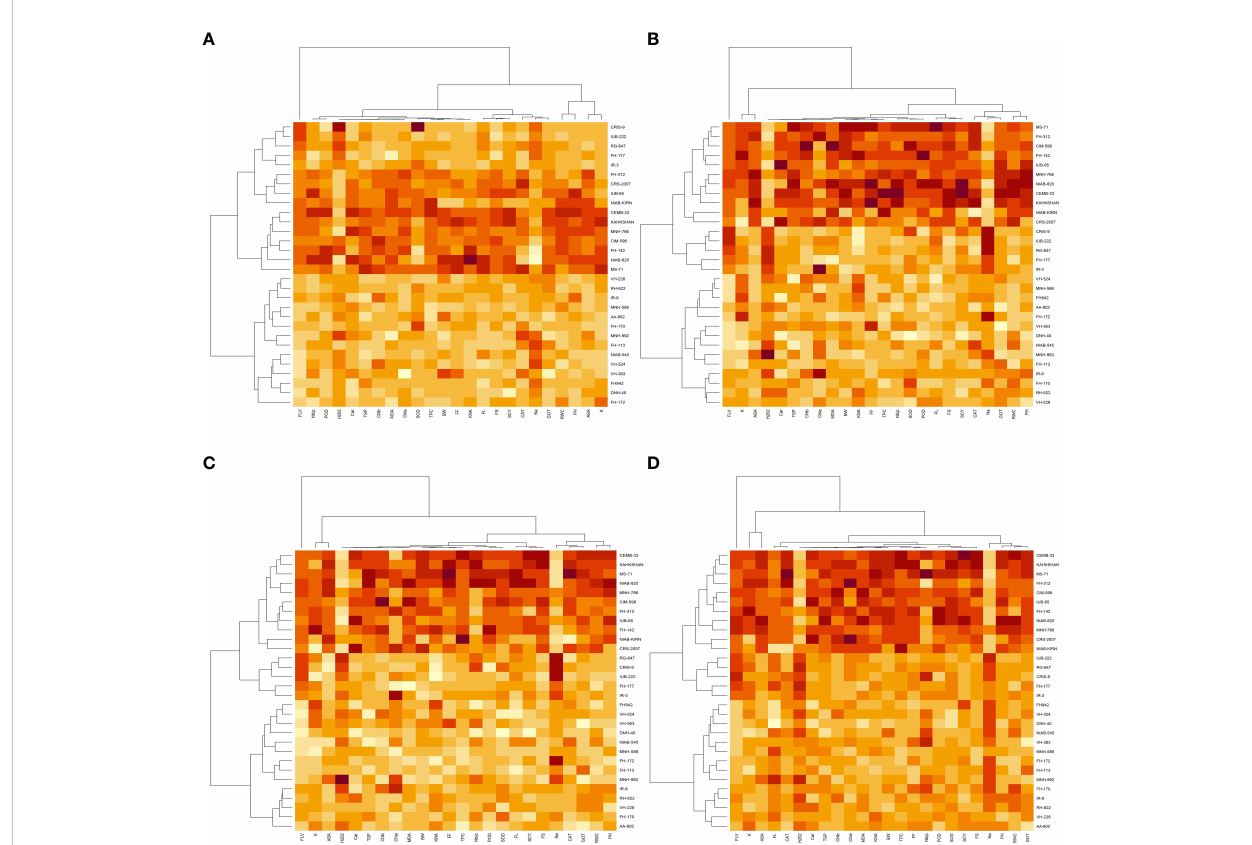
FIGURE 5 First year correlation analysis based on mean values of various agro-physiological, biochemical, and fi ber quality traits of 30 cotton genotypes. (A) control, (B) drought stress (D) , (C) heat stress (H), and (D) drought + heat stress (DH).ASA, ascorbic acid; BW, boll weight; CAR, carotenoids; CAT, catalase; Chla, Chlorophyll a; Chlb, Chlorophyll b; FF, fi ber fi neness; FL, fi ber length; FLV, fl avonoids; FS, fi ber strength; GOT, ginning out turn percentage; H202, Hydrogen peroxide; K+, potassium content; K+/Na+, the potassium over sodium ratio; MDA, malondialdehyde; Na+, the sodium contents; NBP, Number of bolls per plant; PH, plant height; POD, peroxidase; RWC, Relative water content; SCY, seed cotton yield; SOD, superoxide dismutase; TPC, total phenolic content; TSP, total soluble